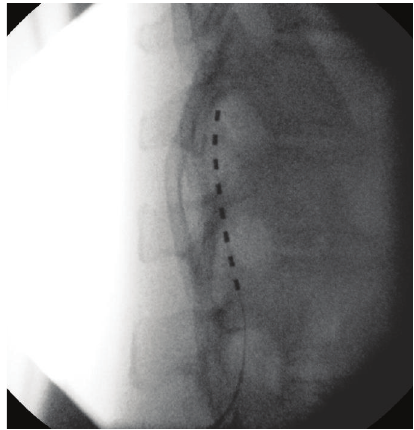
Figure 4: Lateral fluoroscopic view of SCS